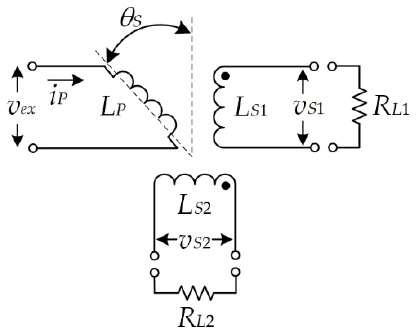
Figure 1. Principle of the functioning of the resolver.